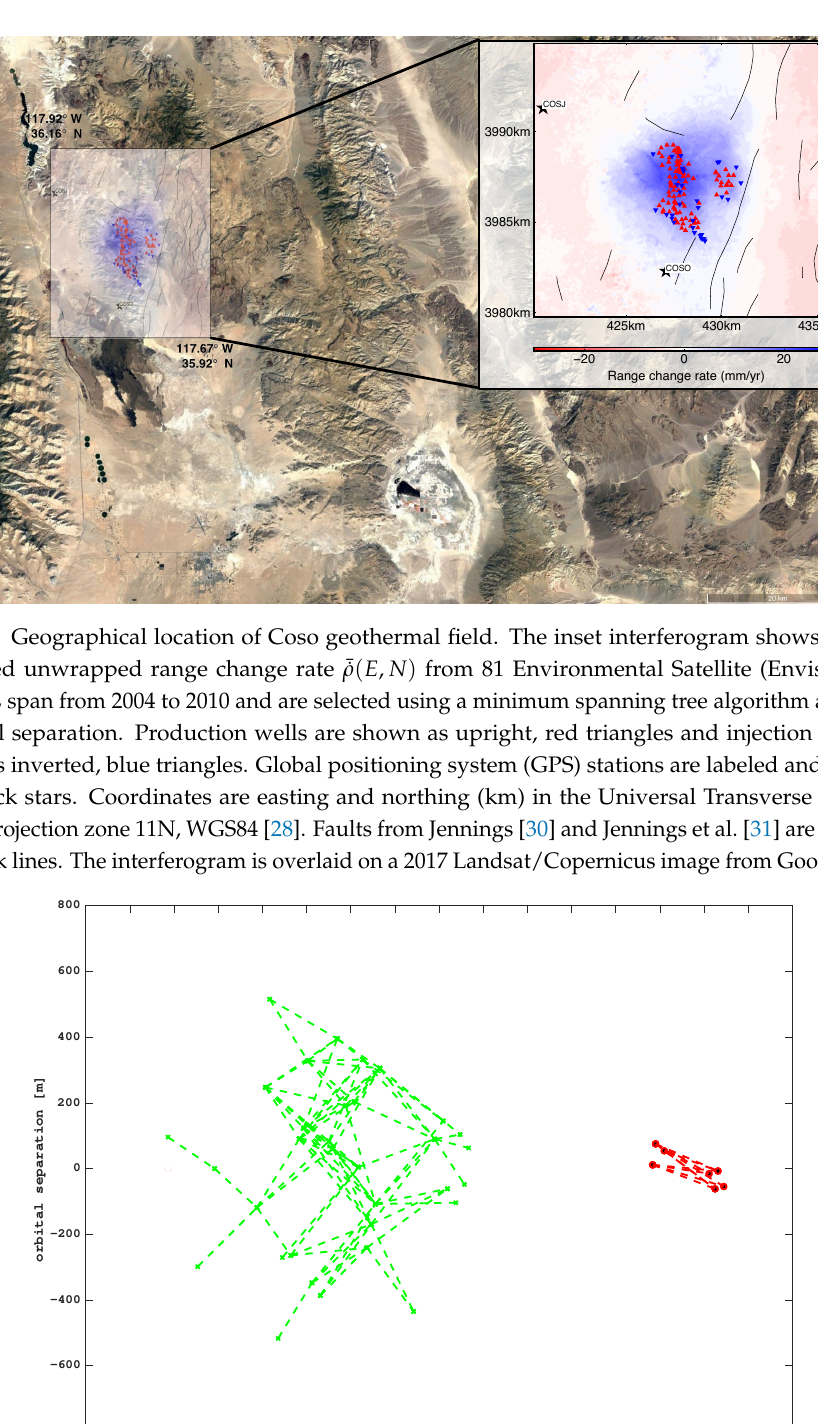
Figure 3. The rate and spatial extent of the deformation field are broadly consistent with InSAR data spanning 1993 to 1999 [8].